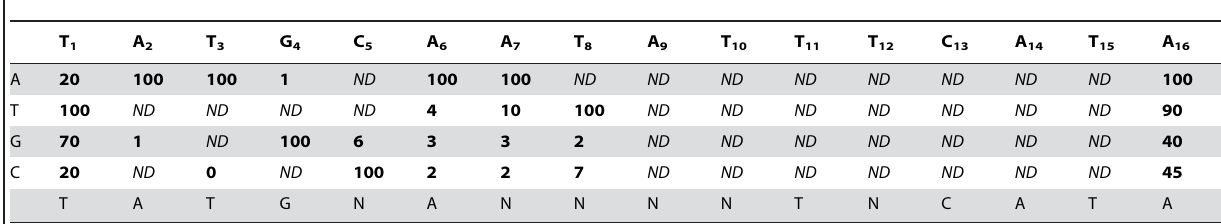
Table 1. Effect of base mutation on the plcA PlcR box